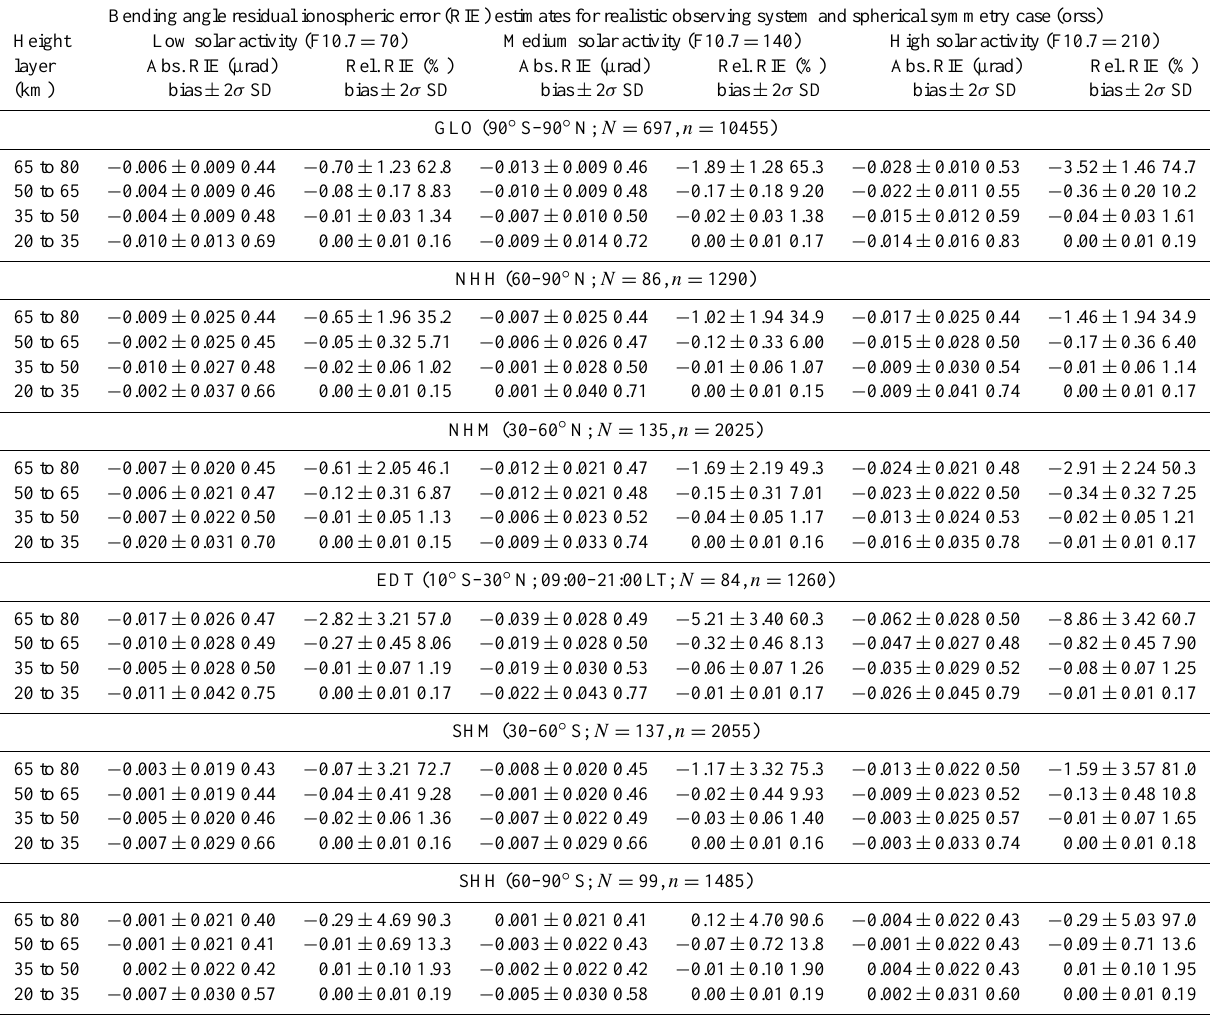
Table 6. Absolute and relative biases, including their 2 σ (95%) confidence ranges, and absolute and relative standard deviations of bending angle RIEs in the same layout as in Table 4 but for the orss